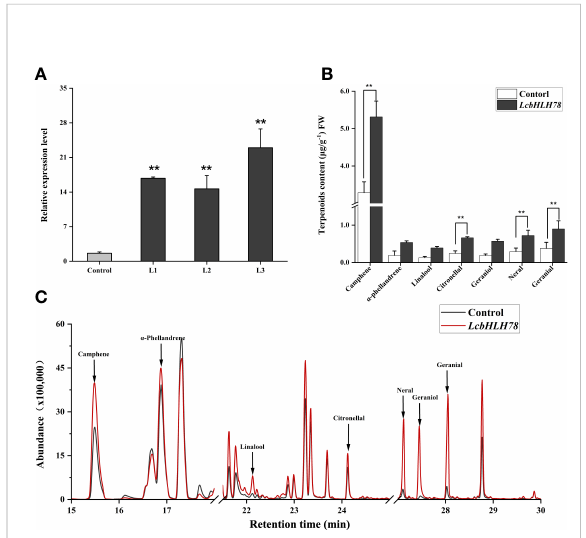
FIGURE 7 (A) Expression levels of LcbHLH78 were signi fi cantly increased compared with the control (highlighted in red). (B, C) Terpenoid levels in sterile seedlings overexpressing LcbHLH78 and sterile L. cubeba leaves infected with Agrobacterium tumefaciens containing LcbHLH78 driven by the 35S promoter were determined using GC-MS. Data are shown as mean ± standard deviation of three replicates